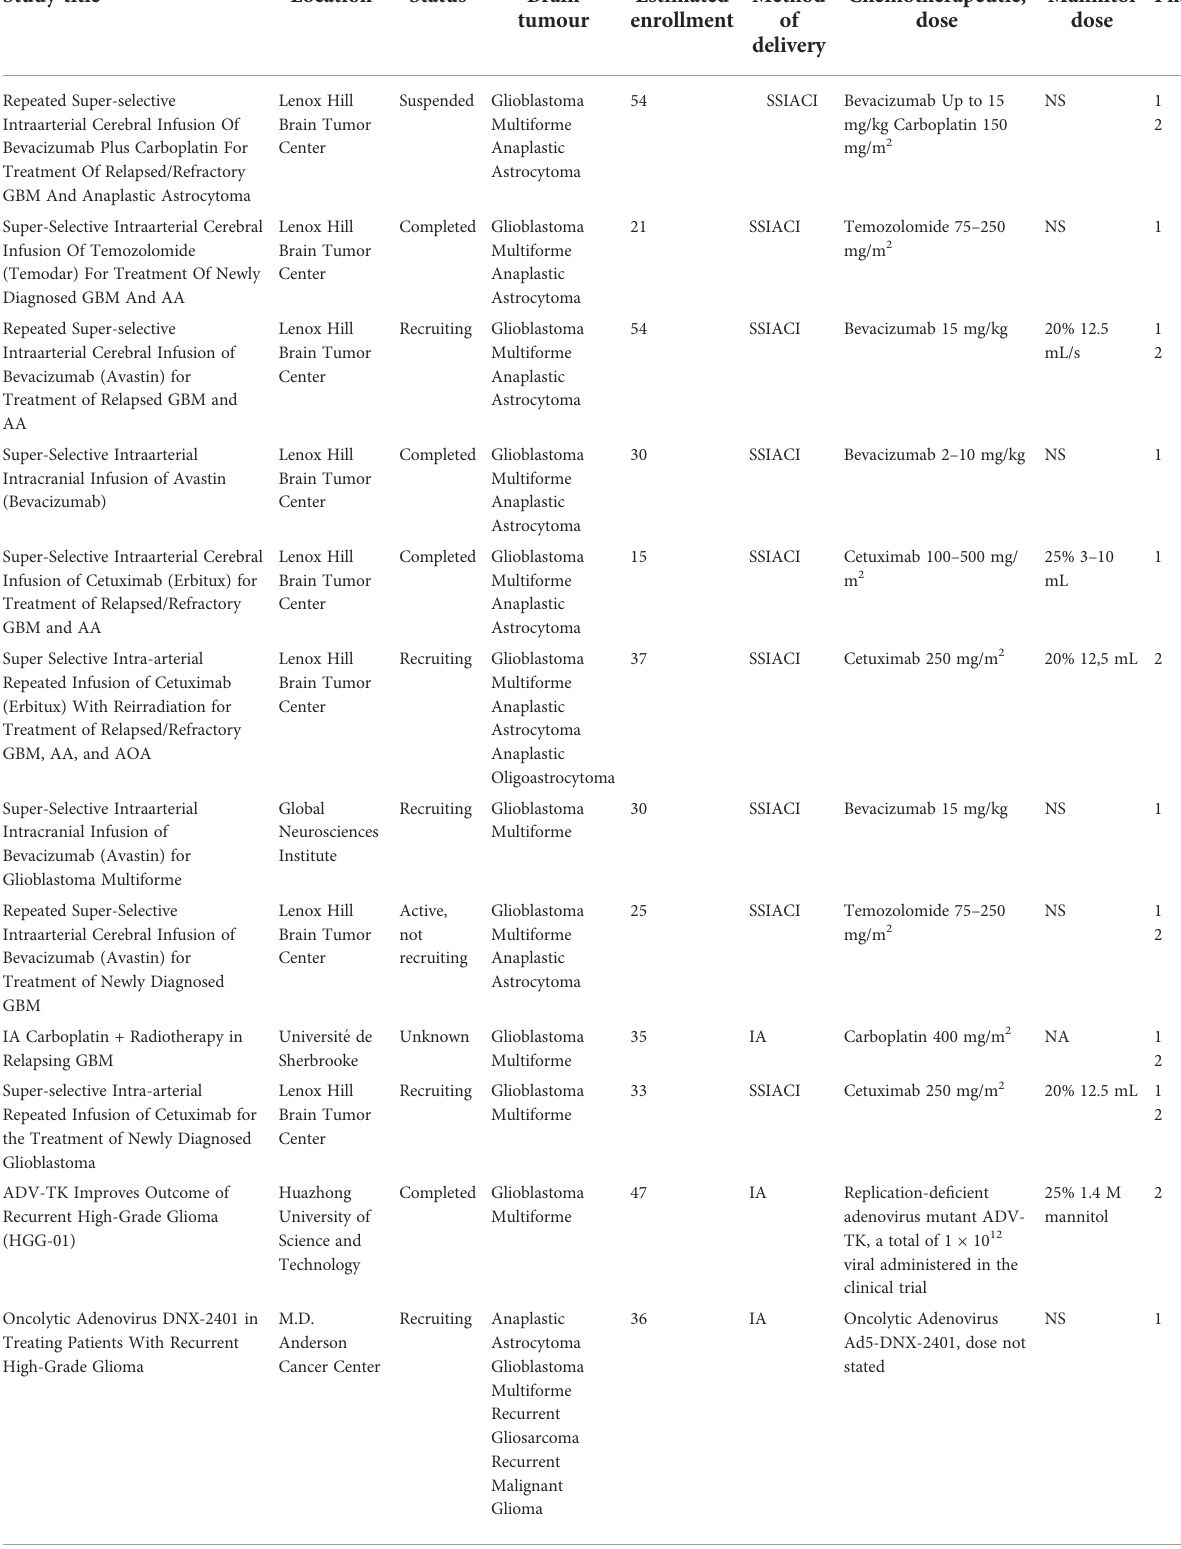
TABLE 2 Current clinical trials concerning the use of IA for the treatment of